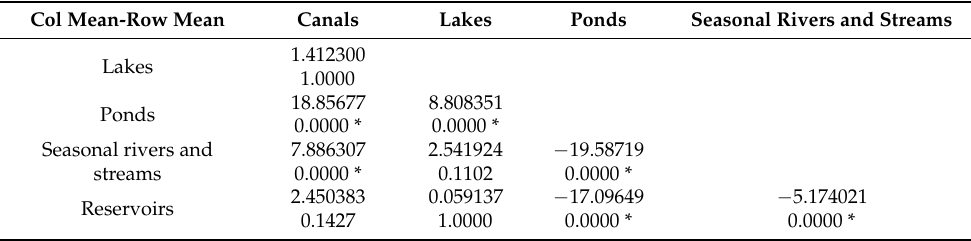
Table A5. 2010 Dunn’s post hoc tests, with p -values adjusted with the Bonferroni method. Col Mean-Row Mean